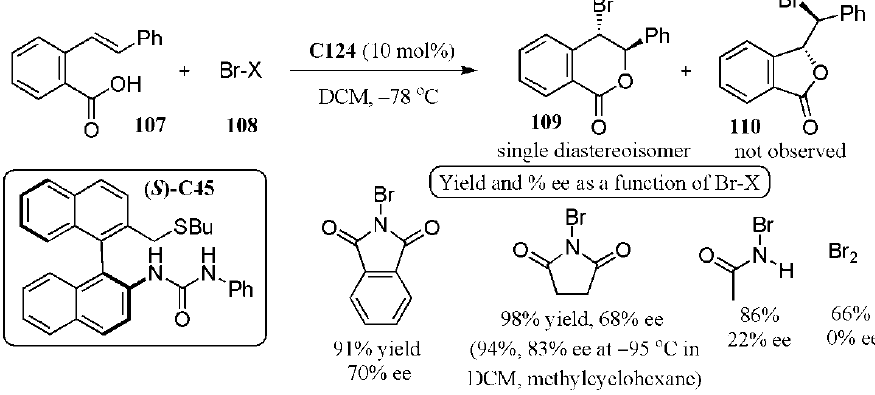
Figure 55. Synthesis of 3,4-dihydroisocoumarin 109 via an asymmetric bromolactonization reac- tion [106].